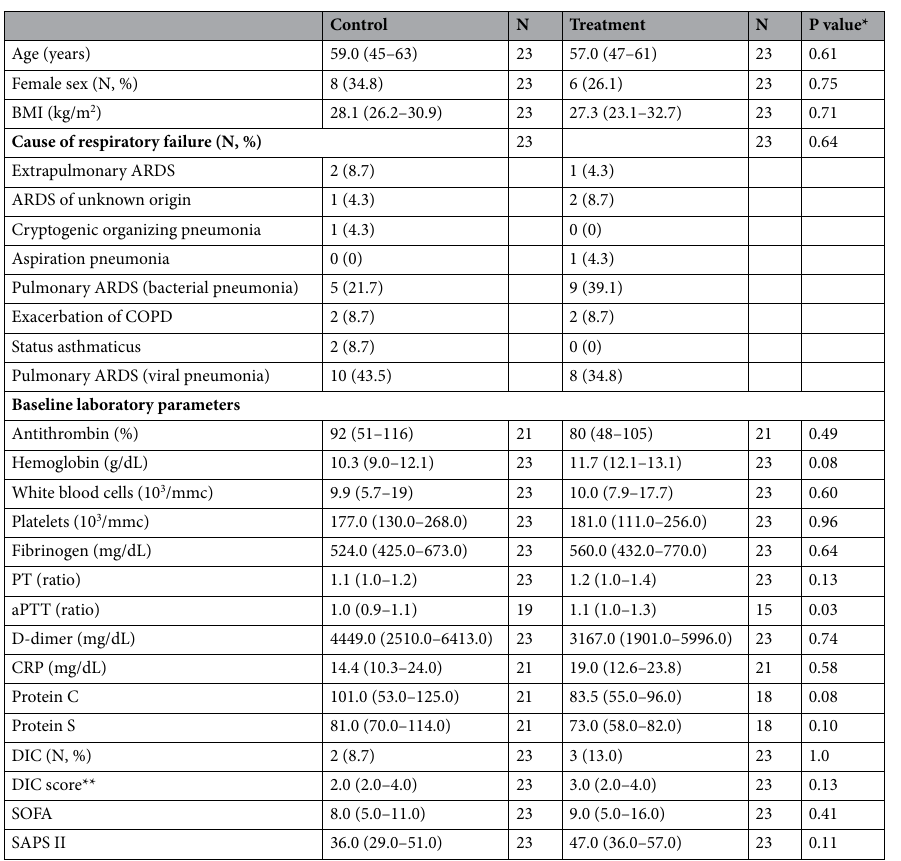
Table 1. Baseline characteristics of the patients. BMI Body Mass Index, DIC disseminated intravascular coagulopathy, SOFA sequential organ failure assessment, SAPS simplified acute physiology score. Values are